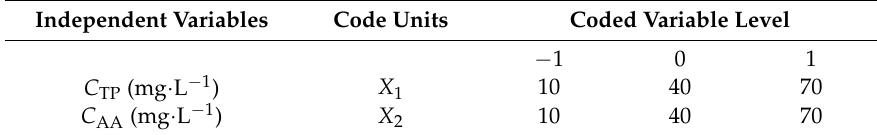
Table 1. Actual values and coded levels of the independent variables used for the experimental design.